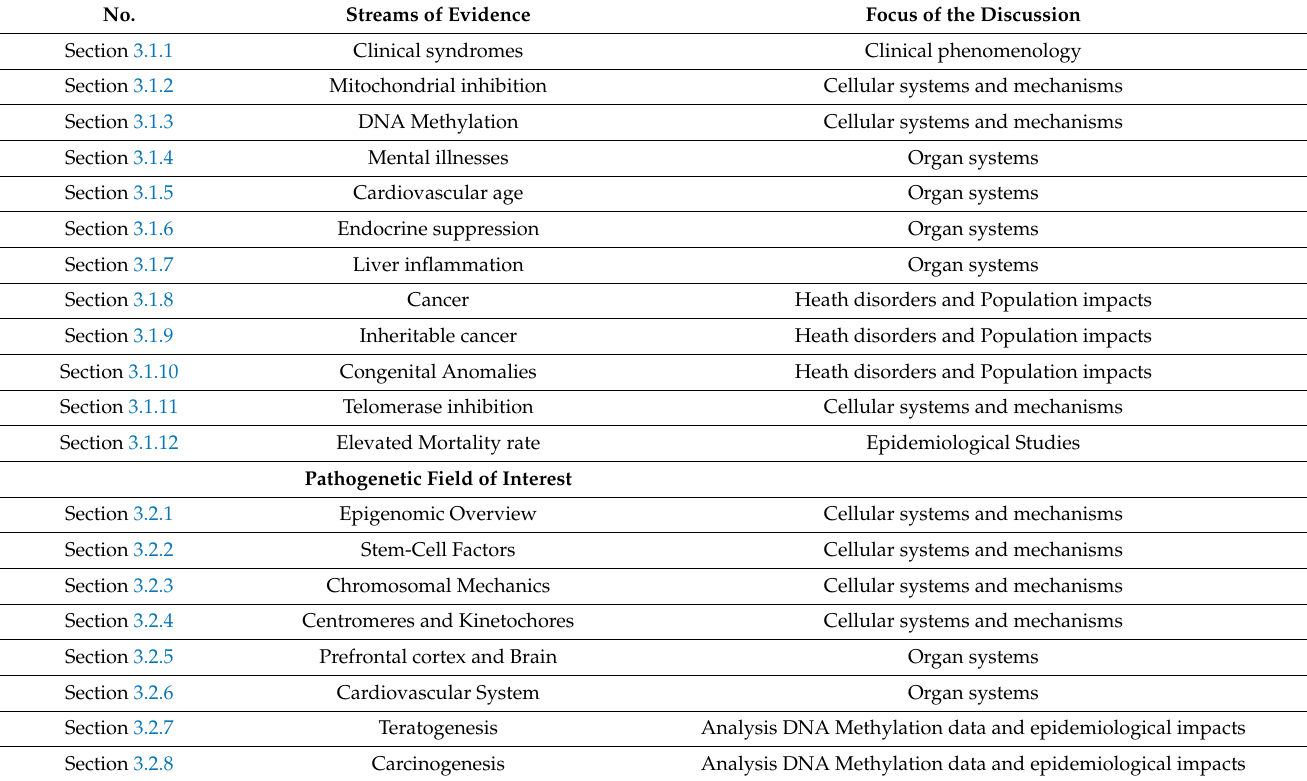
Table 1. Outline of